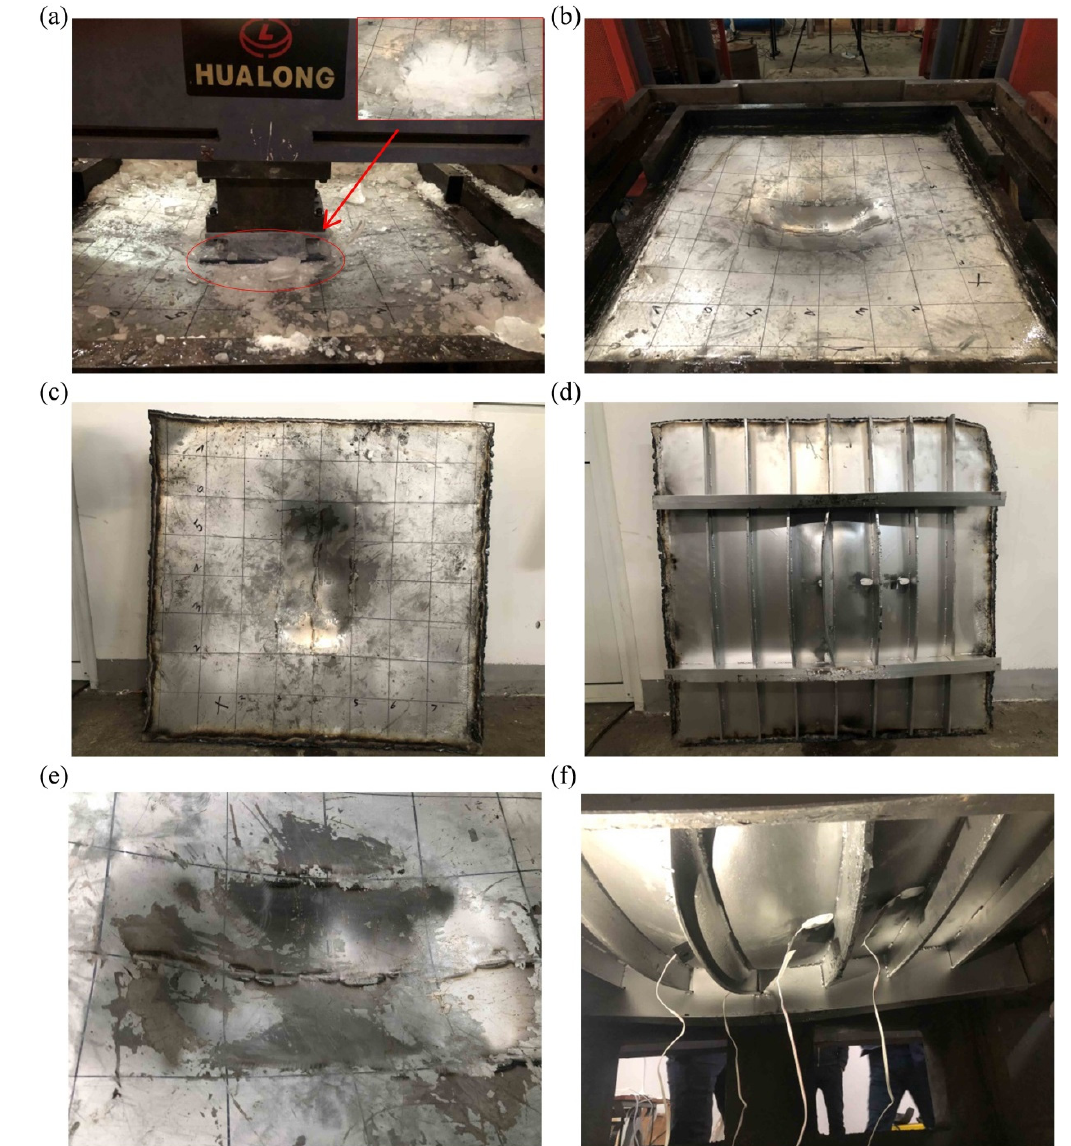
Figure 10. Structural deformation of stiffened panel: ( a ) A photograph of the plate damage after test; ( b ) Overall view; ( c ) Front view; ( d ) Back view; ( e ) Local view, ( f ) Deformation of stiffeners.